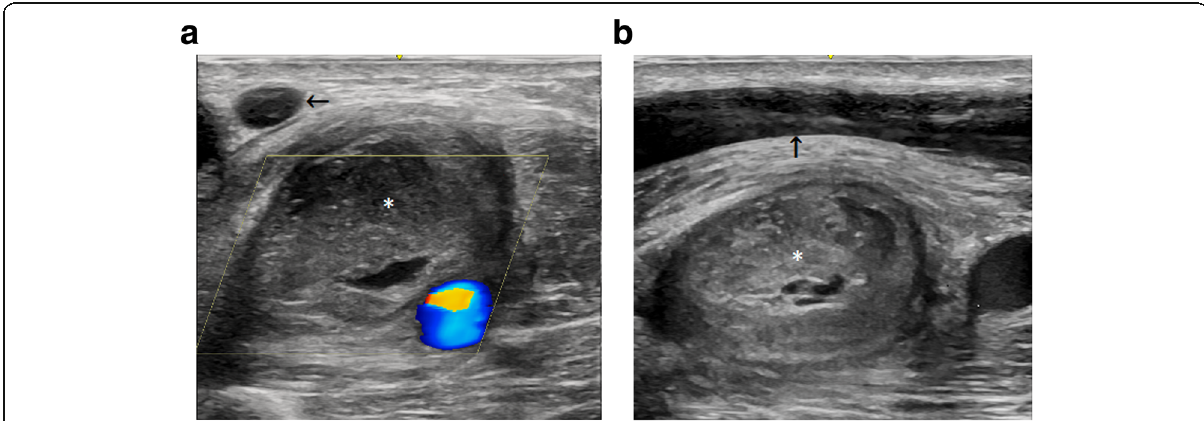
Fig. 3 a . Duplex ultrasound image of the thrombosed pseudoaneurysm (*) in the transverse plane. The cephalic vein (black arrow) and the radial artery are also demonstrated. b . B-Mode ultrasound image of the thrombosed pseudoaneurysm (*) in the longitudinal view. The cephalic vein (black arrow) and the radial artery are also